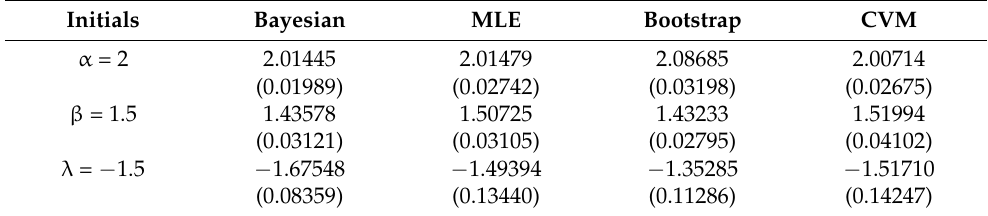
Table 4. The results of the AVs and their corresponding MSEs (in parentheses) for n =